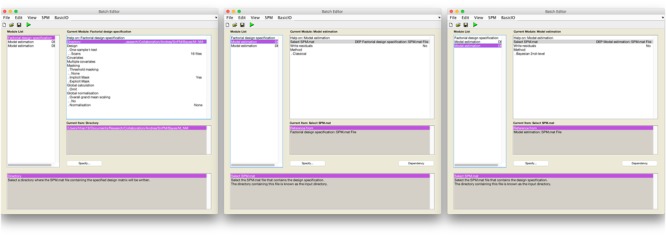
Batch editor settings for Bayesian second-level inference in SPM 12.